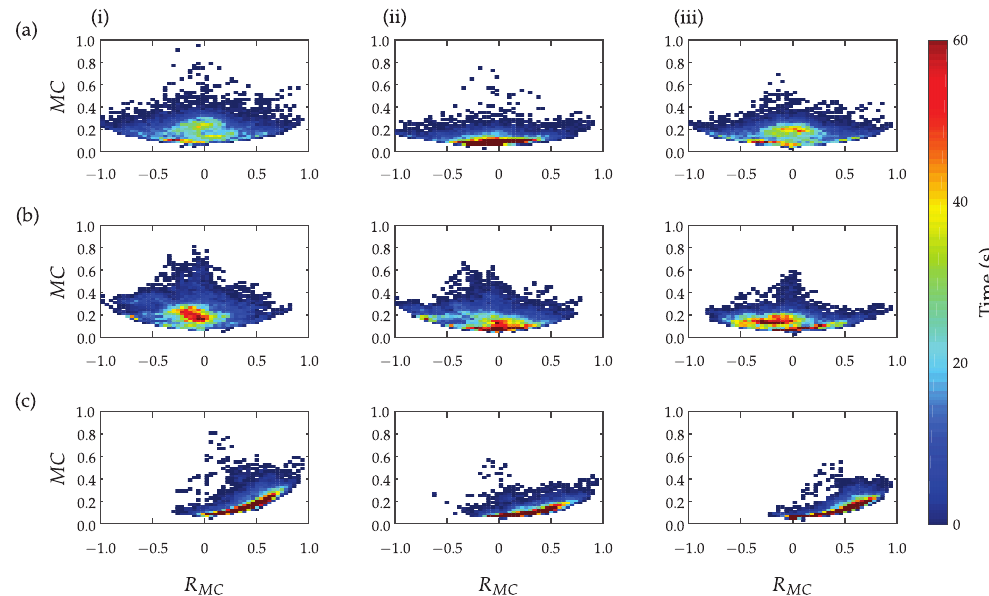
Figure 9. Upper limb muscle activity counts MC in relation to ratio R MC for total forearm flexor and extensor muscles ( i ), for forearm flexors ( ii ), and forearm extensors ( iii ) for a healthy person ( a ) and two stroke patients ( b , c ).